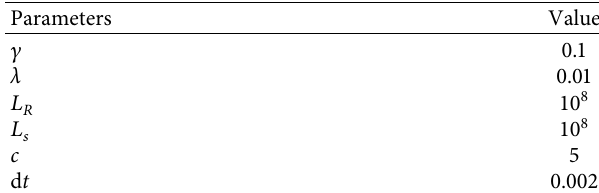
Table 2: Parameters for obtaining K and simulation for τ � 0 . 1s and constant disturbance.